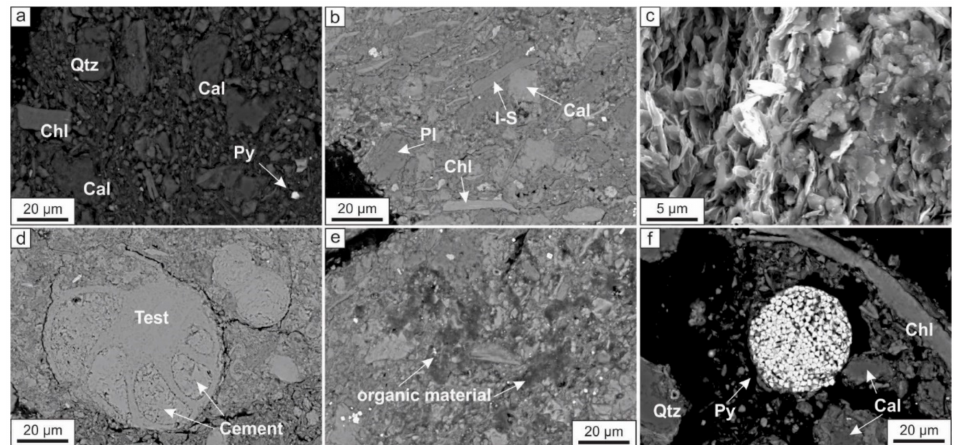
Figure 7. Sediment and rhizo-sediment samples composed of a heterogeneous assemblage of terrigenous fragments that form clasts and authigenic pyrite in a fine-grained matrix dominated by clays and organic material ( a ). Coarser-grained detrital chlorite and illite-smectite (I-S) interstratified-layer clays (I-S) ( b ) and fine-grained authigenic I-S clays in the matrix ( c ). Foraminiferal tests chambers cemented by calcite cement with elevated Mg, Mn and Fe content ( d ). Organic material forms patches within the clay matrix and contains very fine-grained and dispersed sulphide minerals ( e ). Diagenetic pyrite framboids ( f ). Key: Cal–calcite, Chl–chlorite, I-S–illite-smectite interstratified-layer clays, Pl–plagioclase, Py–pyrite,